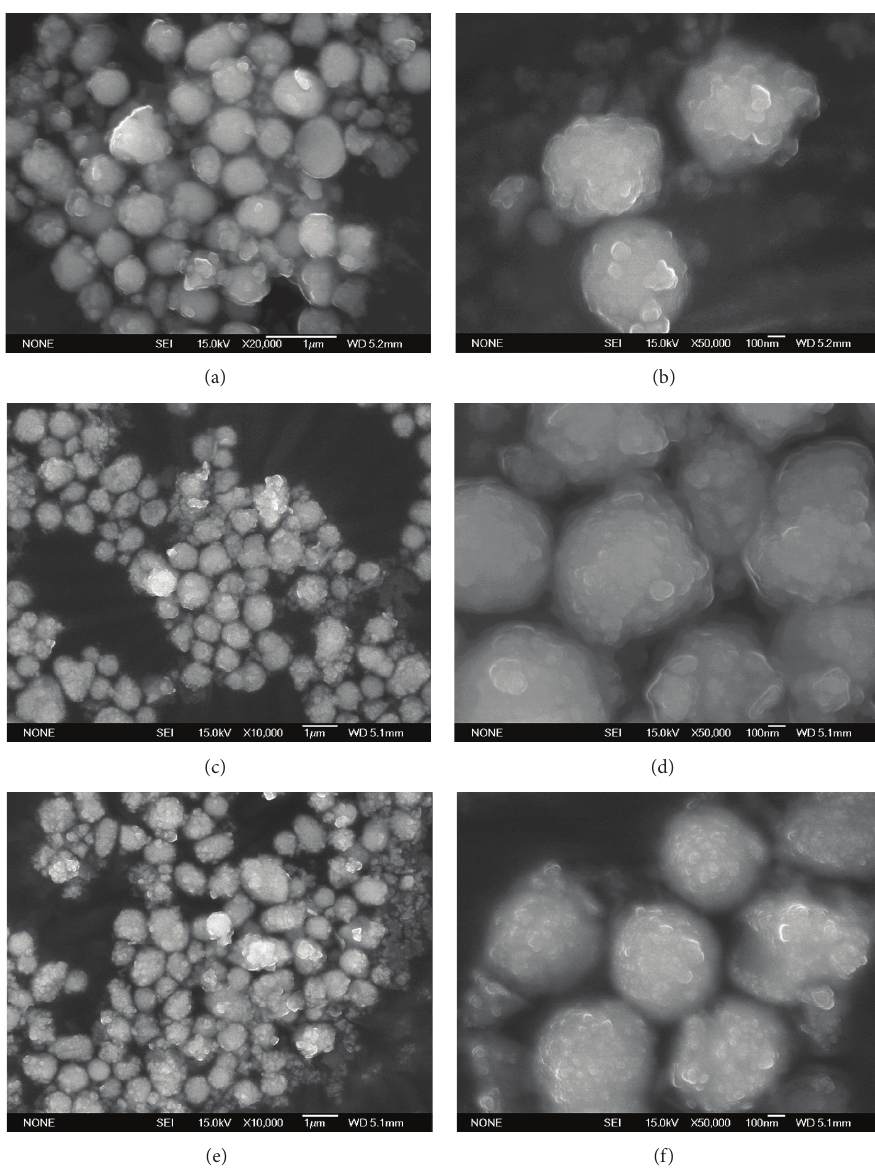
Figure 3: SEM figures of samples Ta (a, b), Tb (c, d), and LTO700 (e,